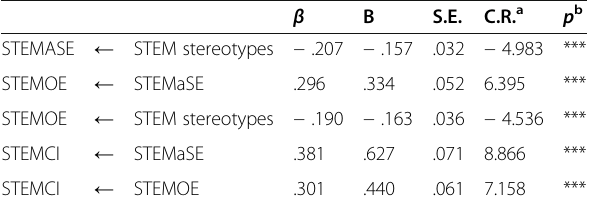
Table 4 Results of the direct effects based on structural equation